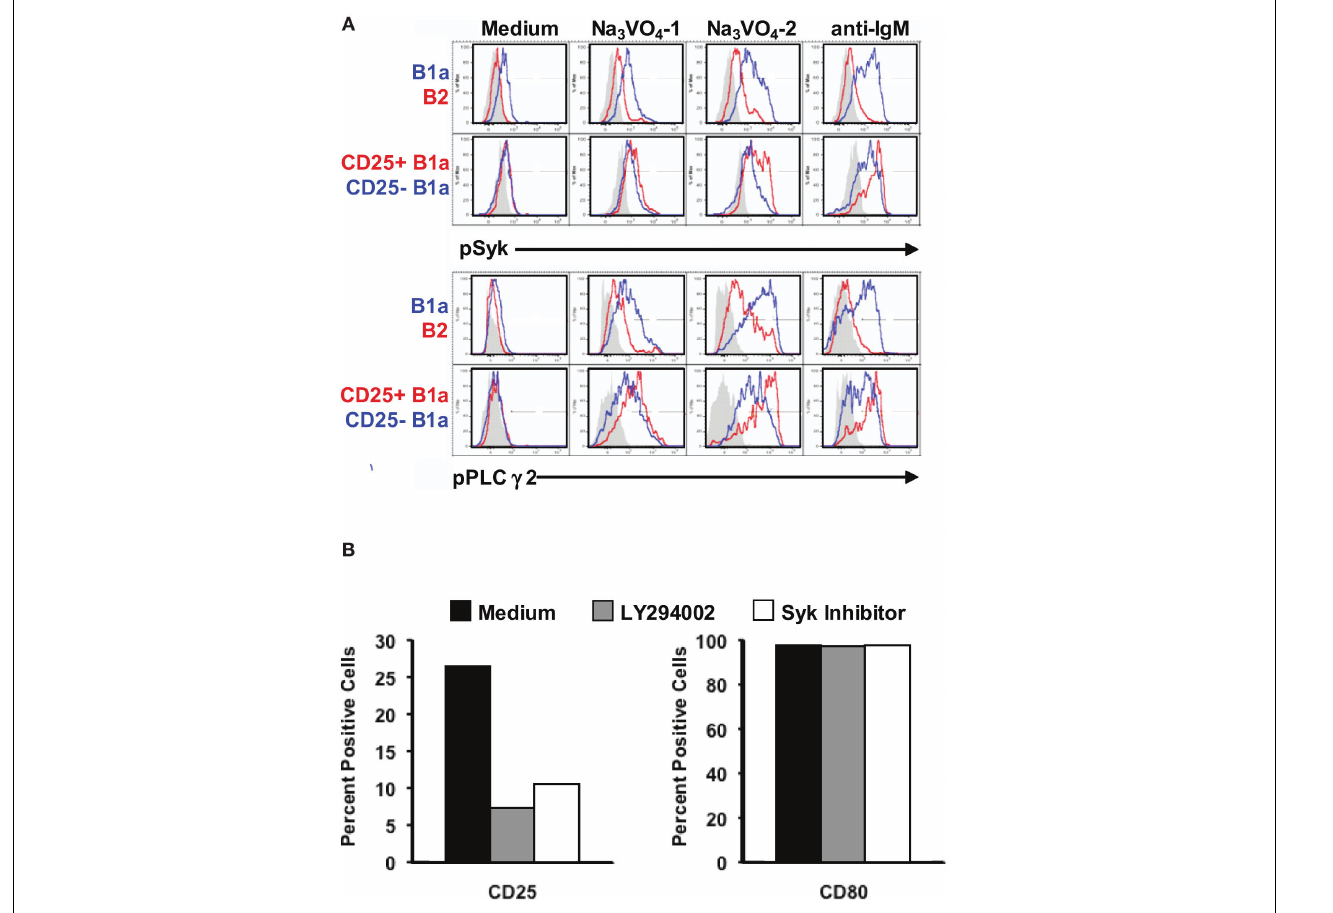
examined for intracellular tyrosine phosphorylated Syk (“pSyk”) and tyrosine phosphorylated PLC γ 2 (“pPLC γ 2”) by phosphoflow analysis. Isotype control antibody staining is displayed in gray. Representative results from one of three comparable experiments are shown. (B) Sort-purified B1a cells were cultured for 18h with either LY294002 or with Syk inhibitor after which expression of CD25 (left panel) and of CD80 (right panel) was assessed by flow cytometry. Mean results from three independent experiments are shown along with lines indicating SE of the